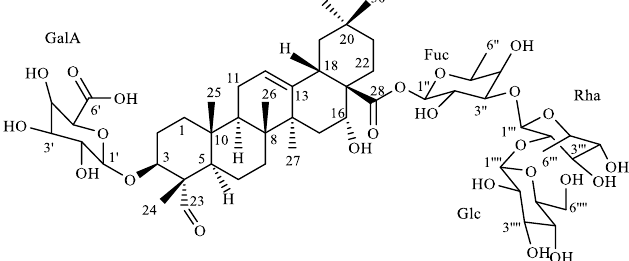
Figure 1. Structure of silviridoside (compound 1